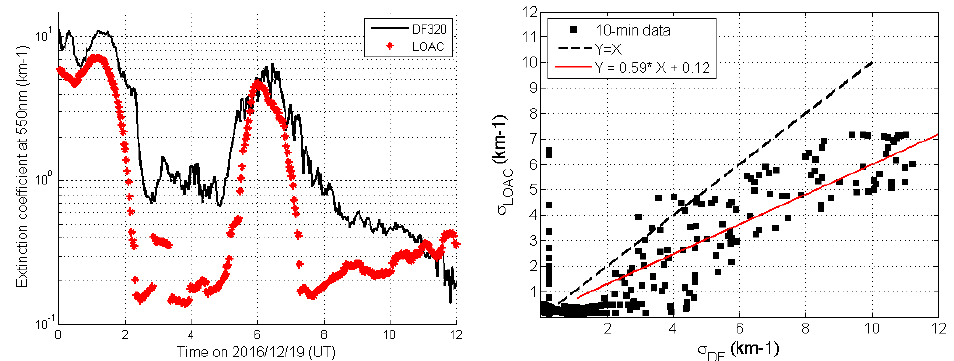
Figure 3. Time series of extinction coefficient derived from LOAC granulometer and DF320 diffusometer ( left ) and scatter plot of LOAC extinction coefficient versus DF320 extinction coefficient for 19 December 2016 ( right ). Table 2. Coefficients used to normalize the LOAC cloud droplet number concentration (CDNC) compared to visible extinction derived from DF320 diffusometer for the four case studies at 4 m agl.